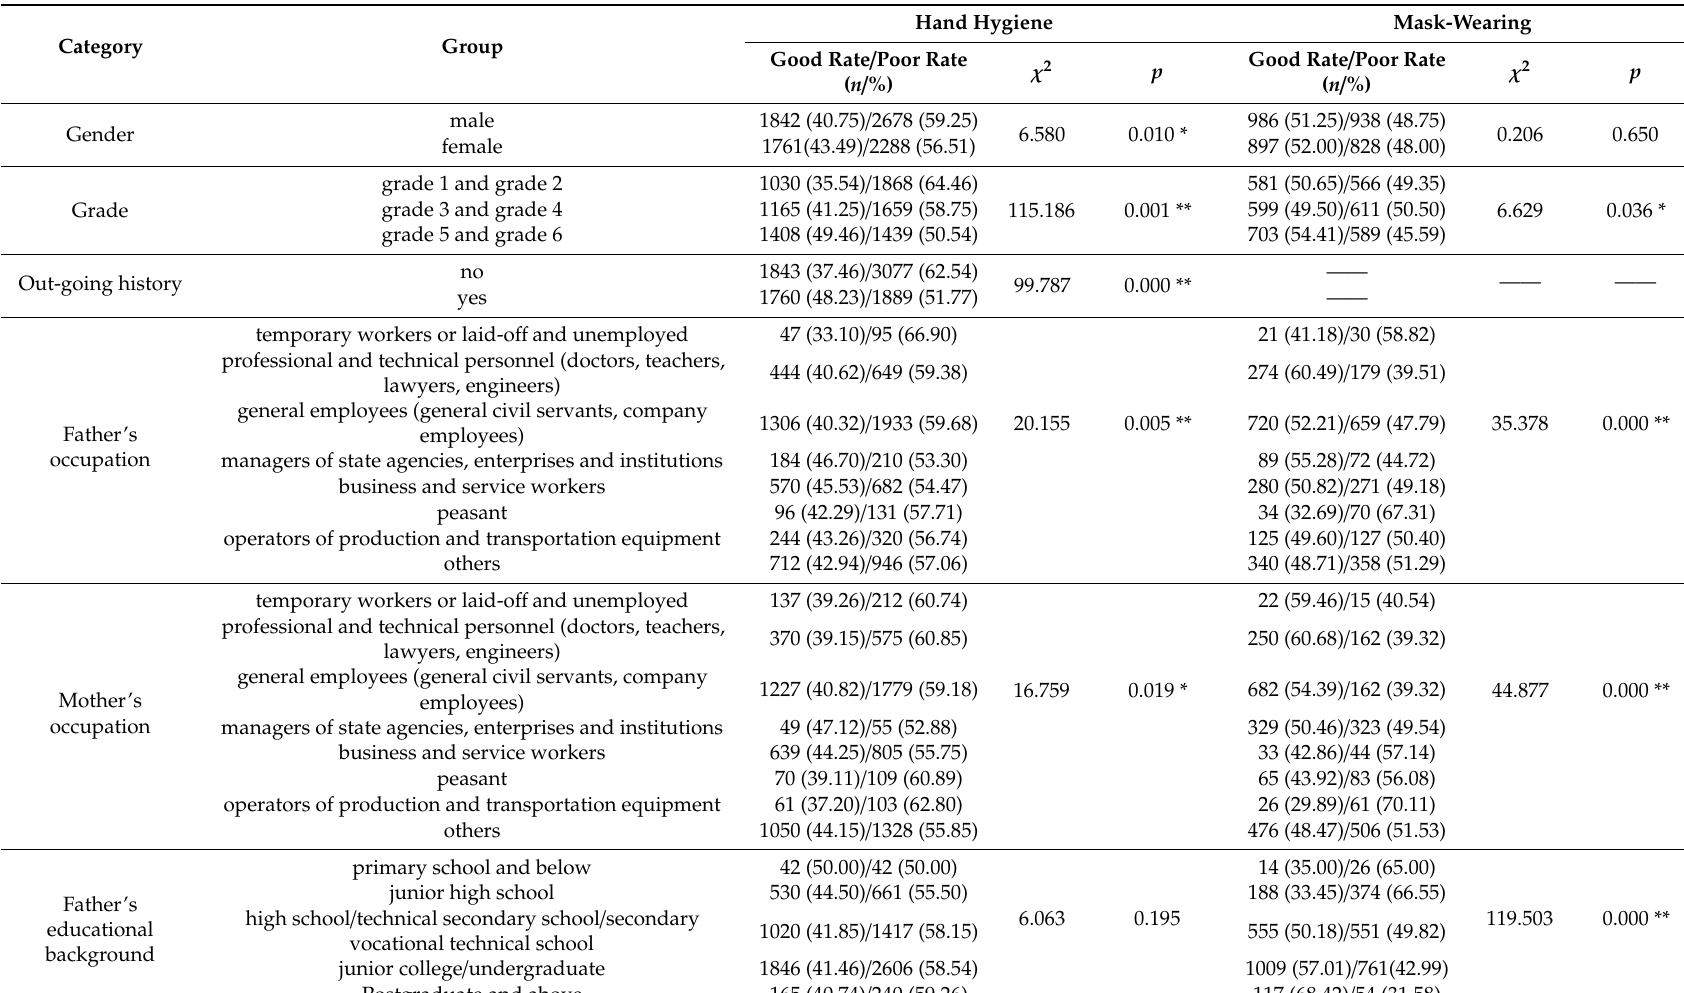
Table 1. Comparison of good rate of hand hygiene ( n = 8569) and mask-wearing ( n = 3649) among pupils in di ff erent groups.